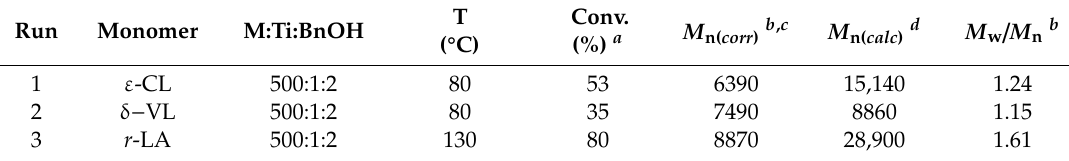
Table 17. ROP of cyclic esters catalyzed by 63 [29].